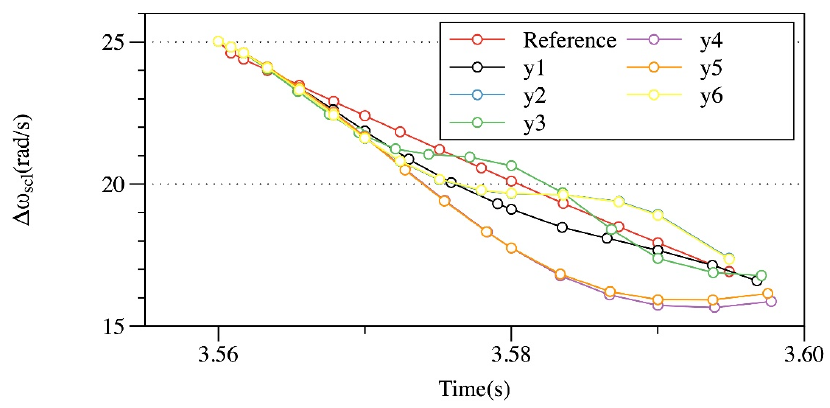
Figure 14. Angular velocity difference between driving and driven clutch pads of the synchronizing clutch.